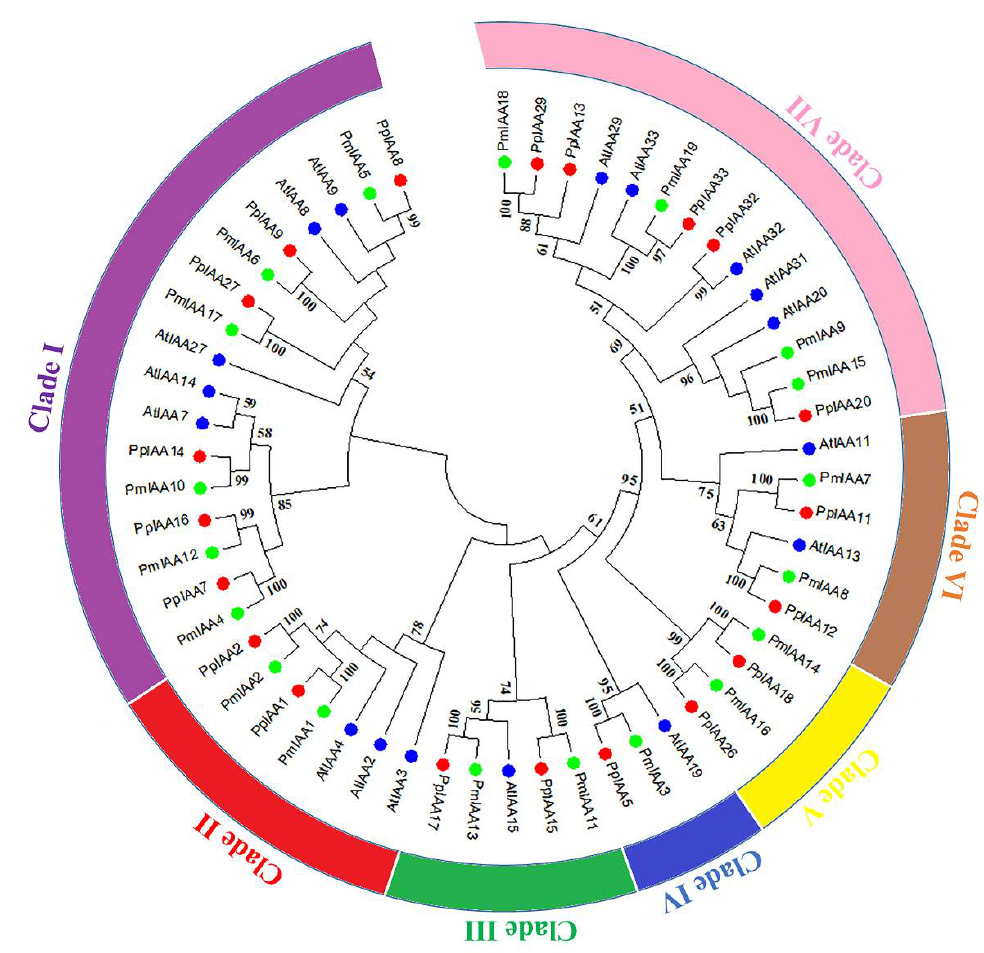
Figure 1. Phylogenetic analysis of PmIAA genes among different family members of Japanese apricot, peach, and Arabidopsis shown in green, red, and blue color dots, respectively. The number on the branches are the bootstrap values and are presented on each node. The outside circle of the phylogenetic tree shows different clades of the tree.